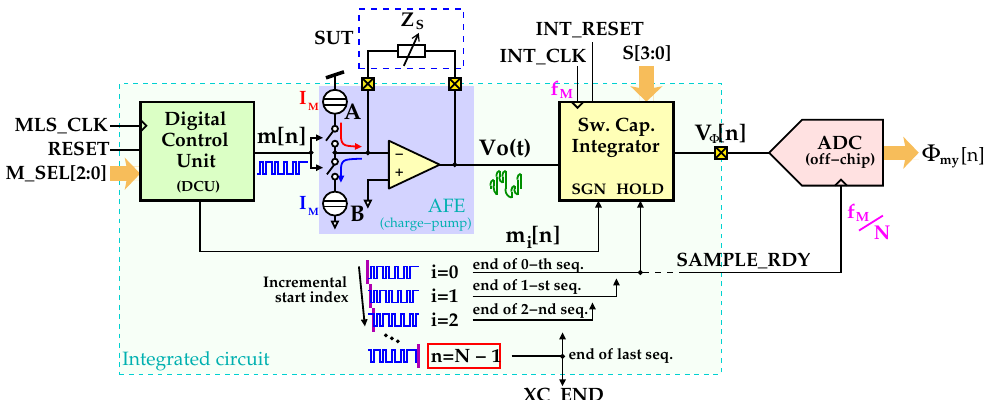
Figure 2. System architecture of the proposed integrated analog and mixed-signal